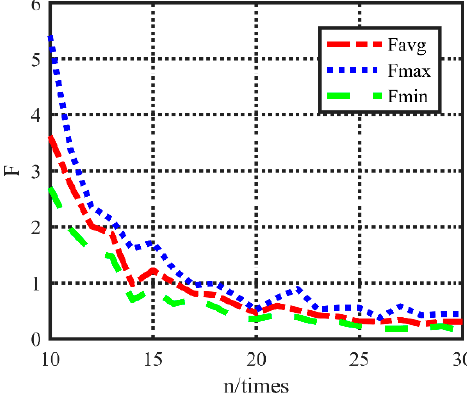
Figure 10. Acquisition frequency vs. error value’s mean value.